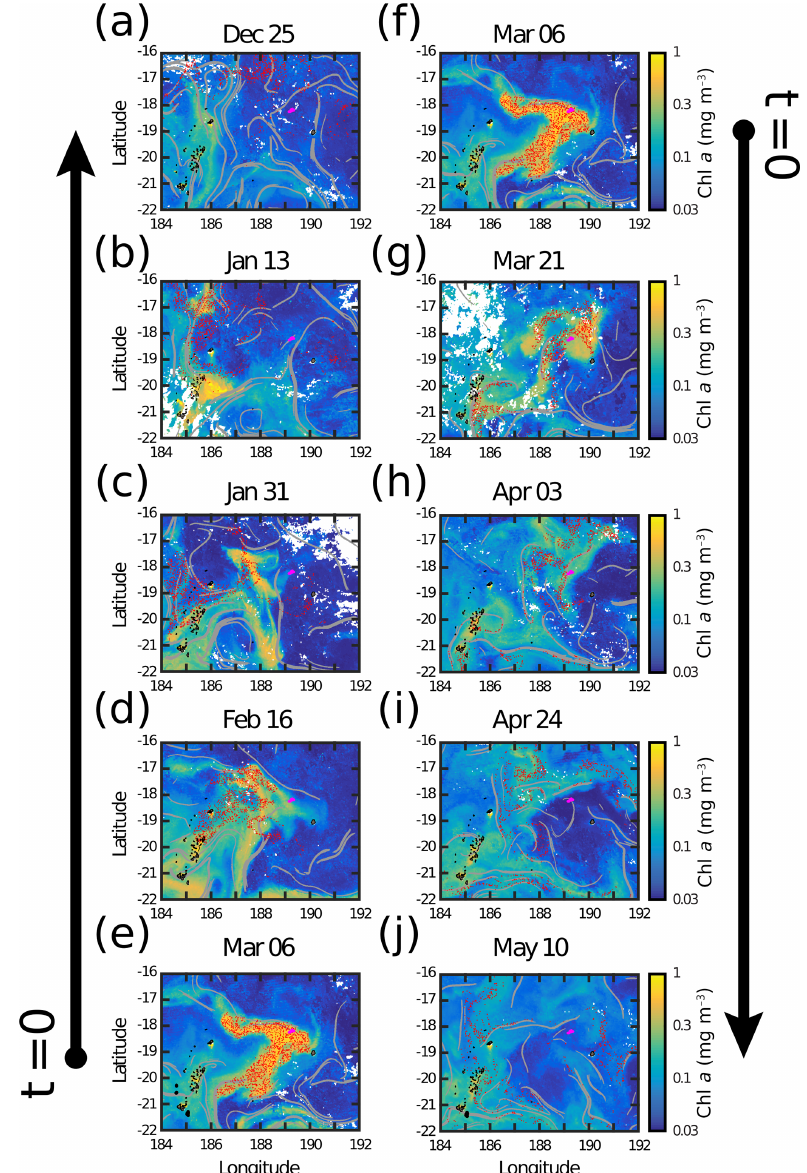
Figure 6. Satellite chl a , FSLE, and ARIANE particles for (a) 25 December 2014, (b) 13 January 2015, (c) 31 January, (d) 16 February, (e–f) 6 March (before station LDB sampling), followed by (g) 21 March (the date of MVP T4), concluded by post-bloom (h) 3 April, (i) 24 April, and (j) 10 May. FSLE values above 0.15day − 1 are shaded gray. LDB CTD locations are shown in magenta. A randomly selected subsampling of one-tenth of the ARIANE particles was initially chosen to be shown in